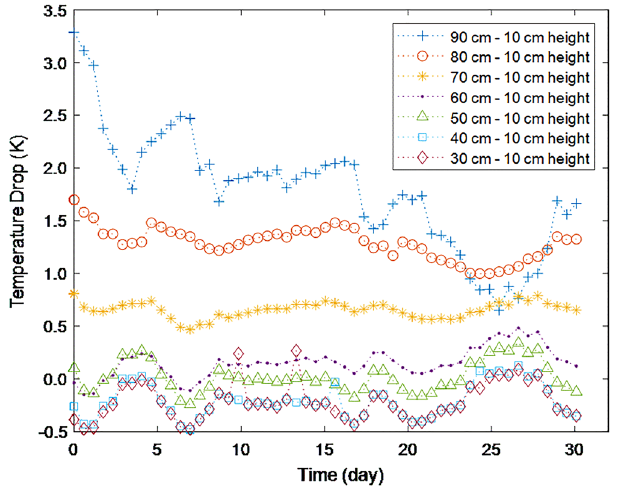
Figure 3. The temperature drops at various heights along the centerline compared to the 10 cm height for an insulated air column of 60 cm diameter, measured for 30 days from June 18th, 2021, in Gyeongju, Korea.